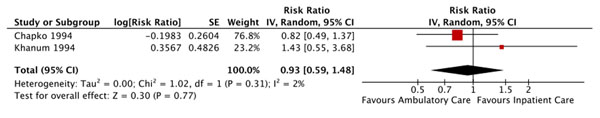
Forest plot for the effect of impatient vs. ambulatory care on mortality in SAM